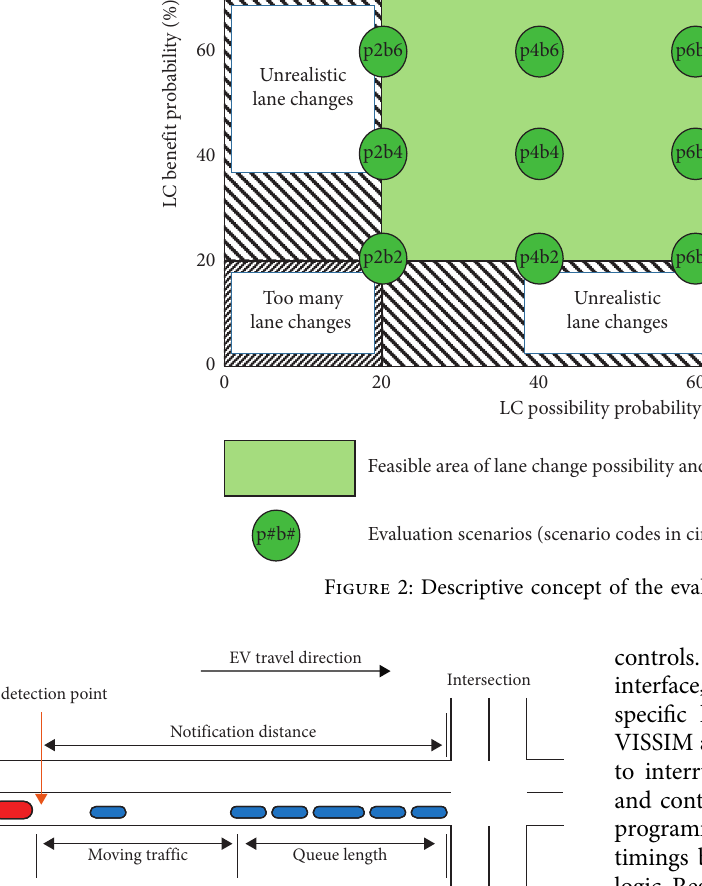
Figure 3: Dynamic notification distance based on queue